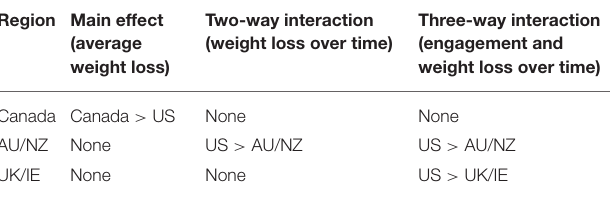
TABLE 5 | Summary of cross-region engagement and weight loss differences. Region Main effect (average weight